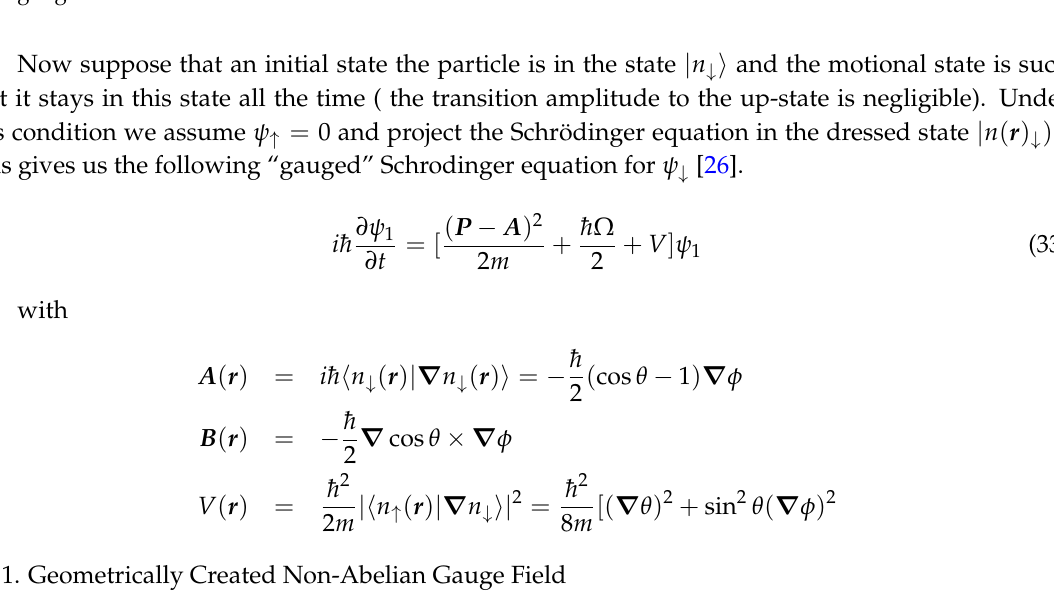
Figure 3. Typical atom-laser configuration to create geometrical ( a ) Abelian and ( b ) Non Abelian gauge